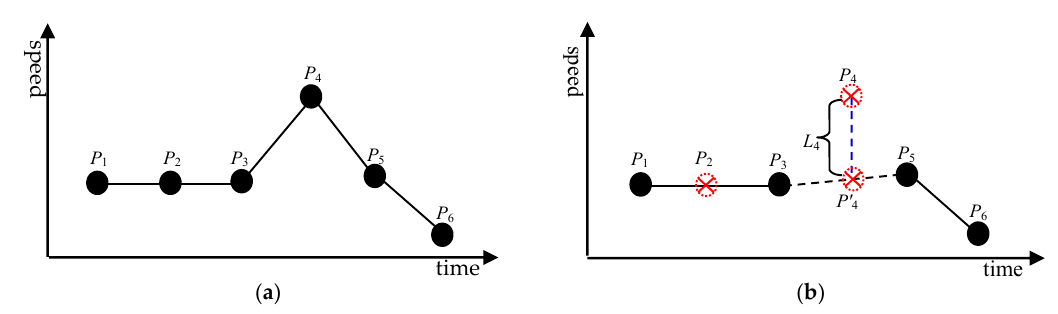
Figure 4. Speed loss through trajectory simplification: ( a ) speed–time graph of a trajectory; and ( b ) speed loss at P 4 with incorrect trajectory simplification that fails to preserve P 4 .